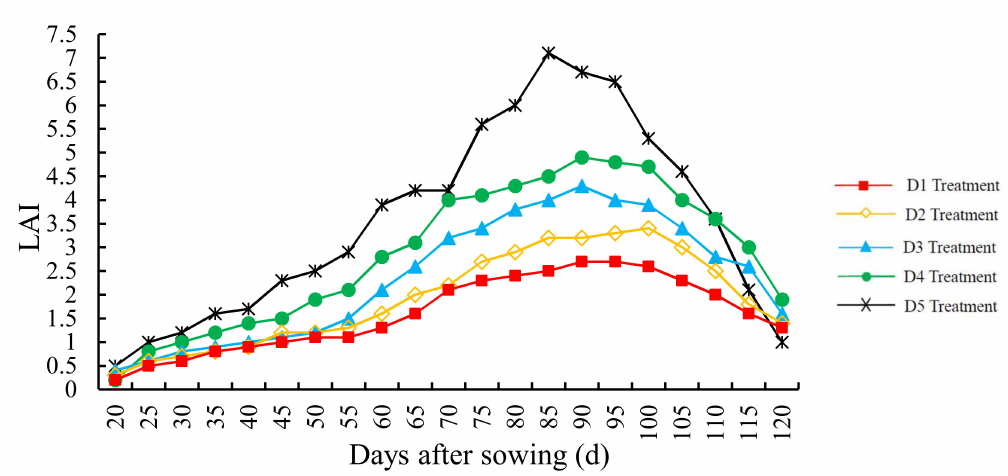
Figure 9. Variation of leaf area index (LAI) during the sunflower growth period in 2016.